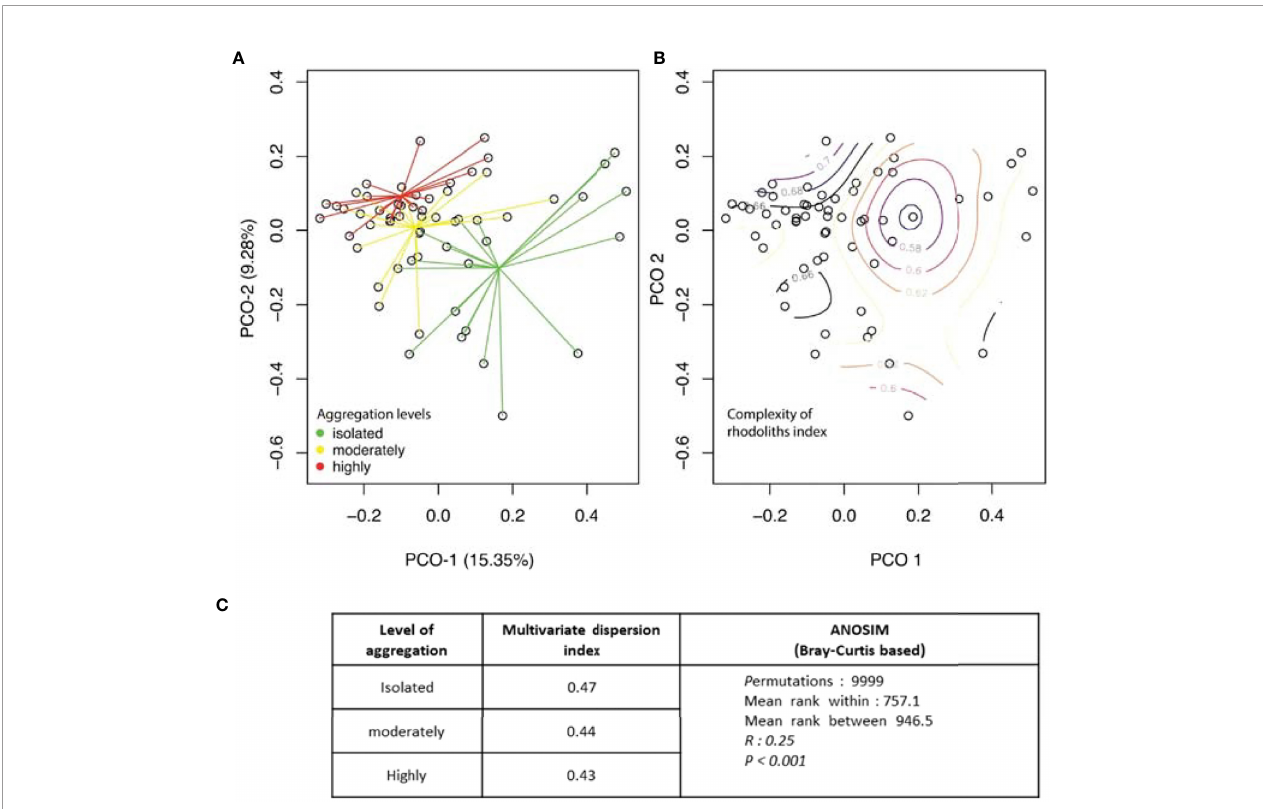
FIGURE 7 | Principal coordinate analysis based on Bray – Curtis of the abundance of invertebrates in rhodolith samples by (A) the level of aggregation of the rhodolith bed and (B) the value of complexity of the rhodoliths (Isla del Coco). (C) Comparison of multivariate dispersion indexes generated by betadisper (R, library “ vegan ” ) and PERMANOVA analysis of internal variation in species composition.